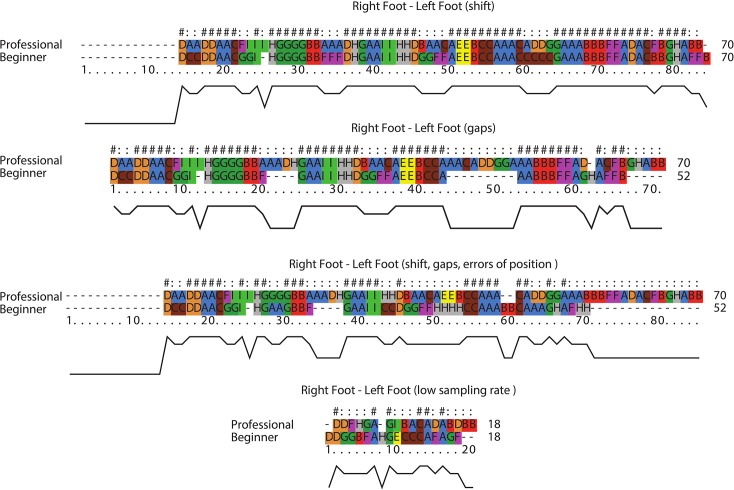
Sample results of QTCB alignment for incomplete data.